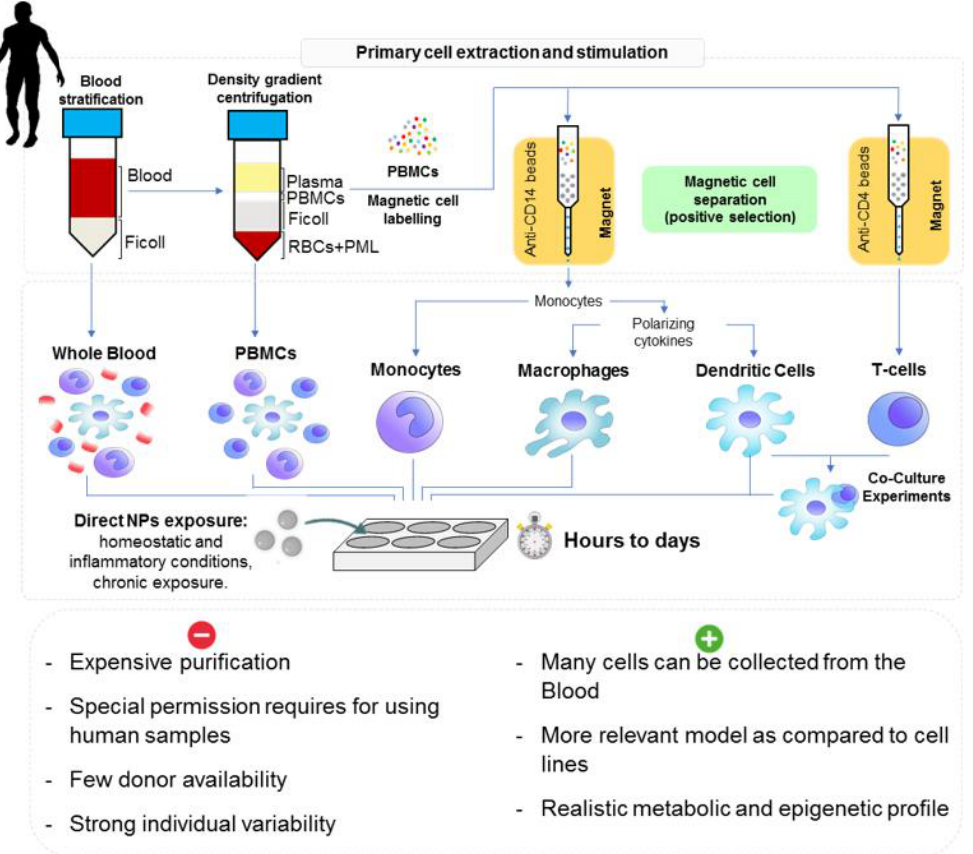
Figure 5. The different in vitro NP exposure possibilities available for human primary cells and the procedure of cell extraction and preparation (Reprinted with permission from Michelini et al. (2021) [153]. Copyright 2021, Copyright Royal Society of Chemistry).